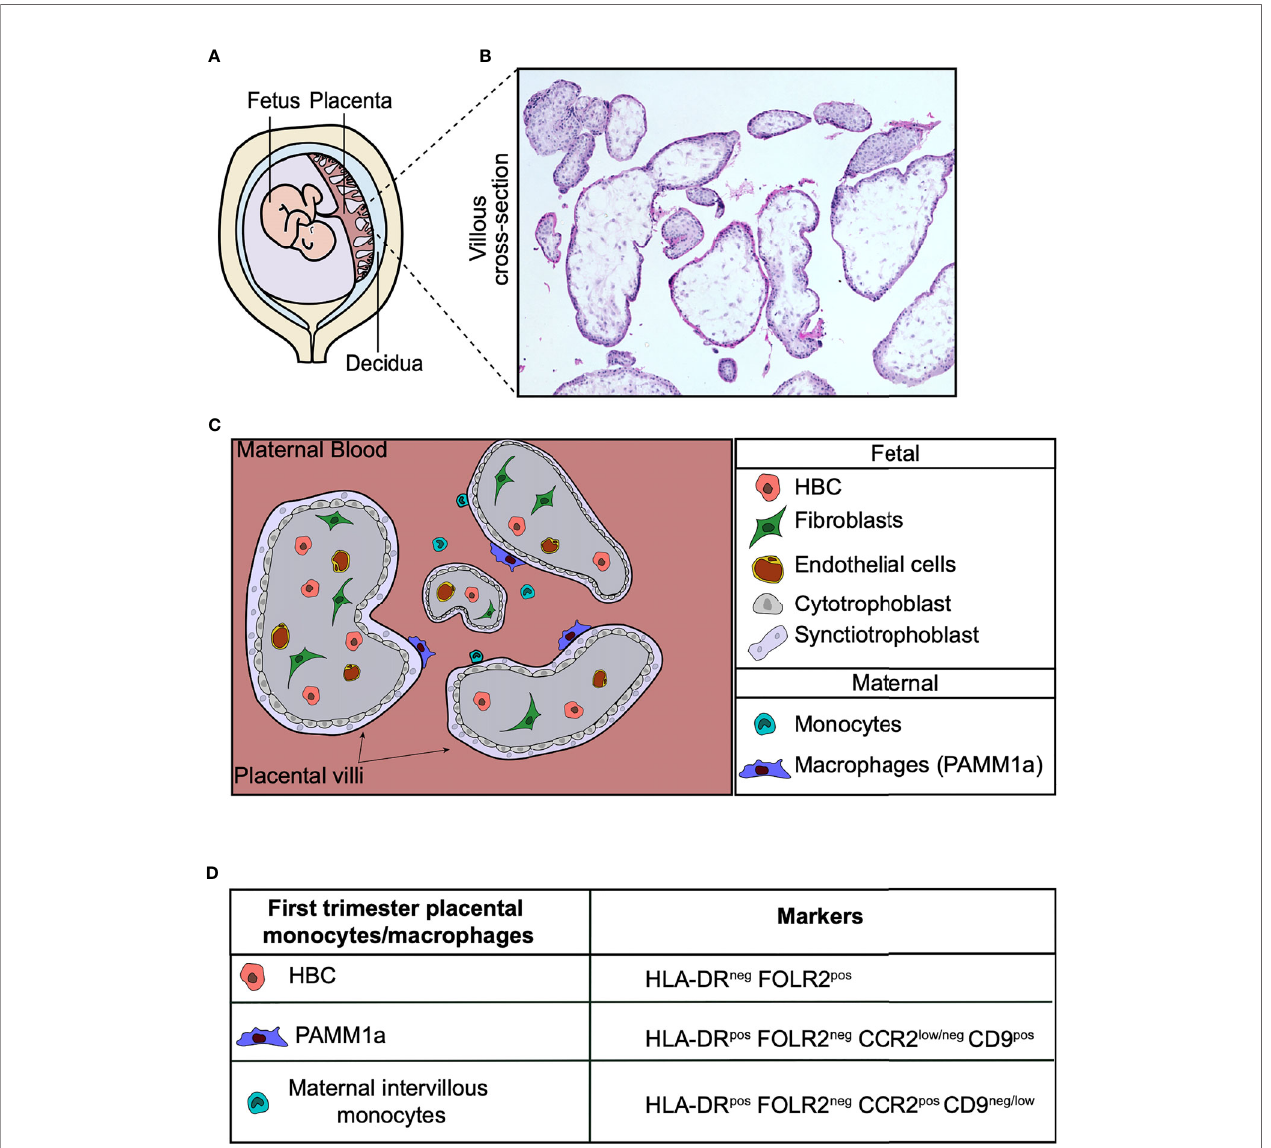
FIGURE 1 | Human placental macrophages. (A) Illustration of the human placenta. (B) Hematoxylin and eosin stain of fi rst trimester placental villi. (C) Cross-section diagram of fi rst trimester placental villi indicating the localization of placental macrophages. (D) Surface markers of monocyte and macrophage populations found in fi rst trimester placental digests. Hofbauer cells (HBC), PAMM1a (placental associated maternal